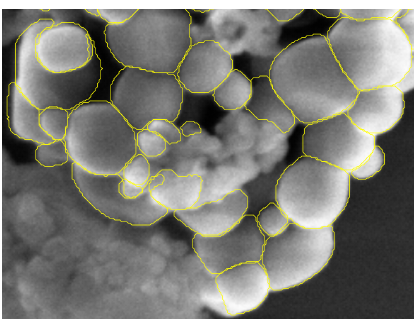
Figure 12. Predicted segmentation over SEM image of TiO 2 particles in the presence of SiO 2 particles, zoom ×